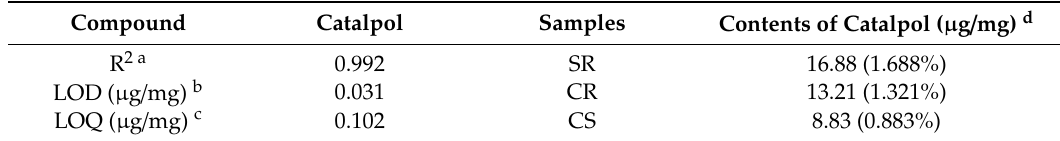
Table 3. Linearity of the standard curve and detection / quantification limits for the catalpol standard and quantitative analysis of